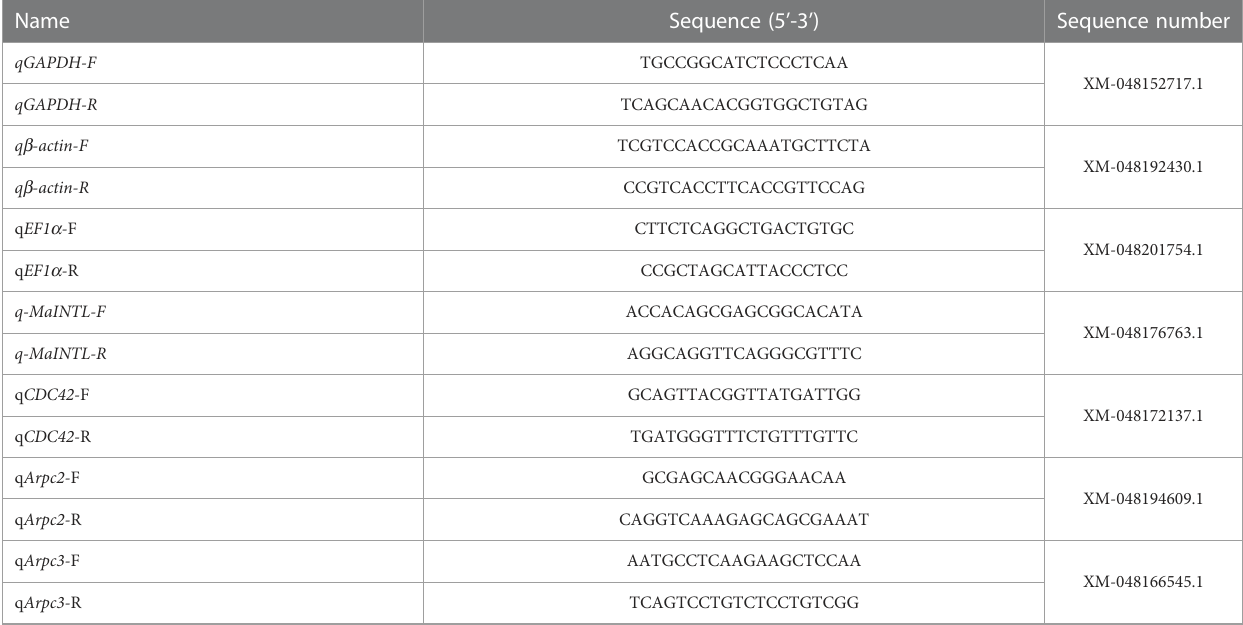
TABLE 1 Primers used for RT-qPCR in the present